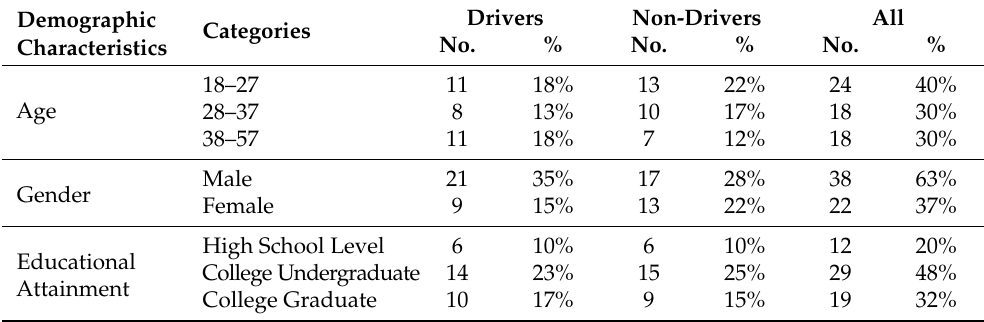
Table 2. Demographic Characteristics of